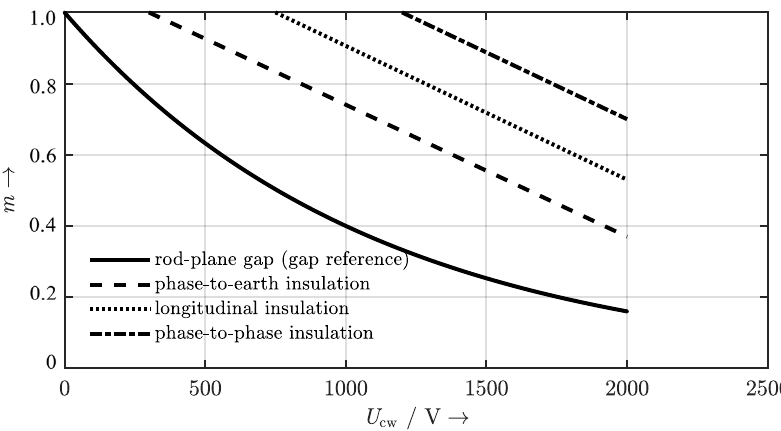
Figure 4. Functions m ( U cw ) according to and after [2]